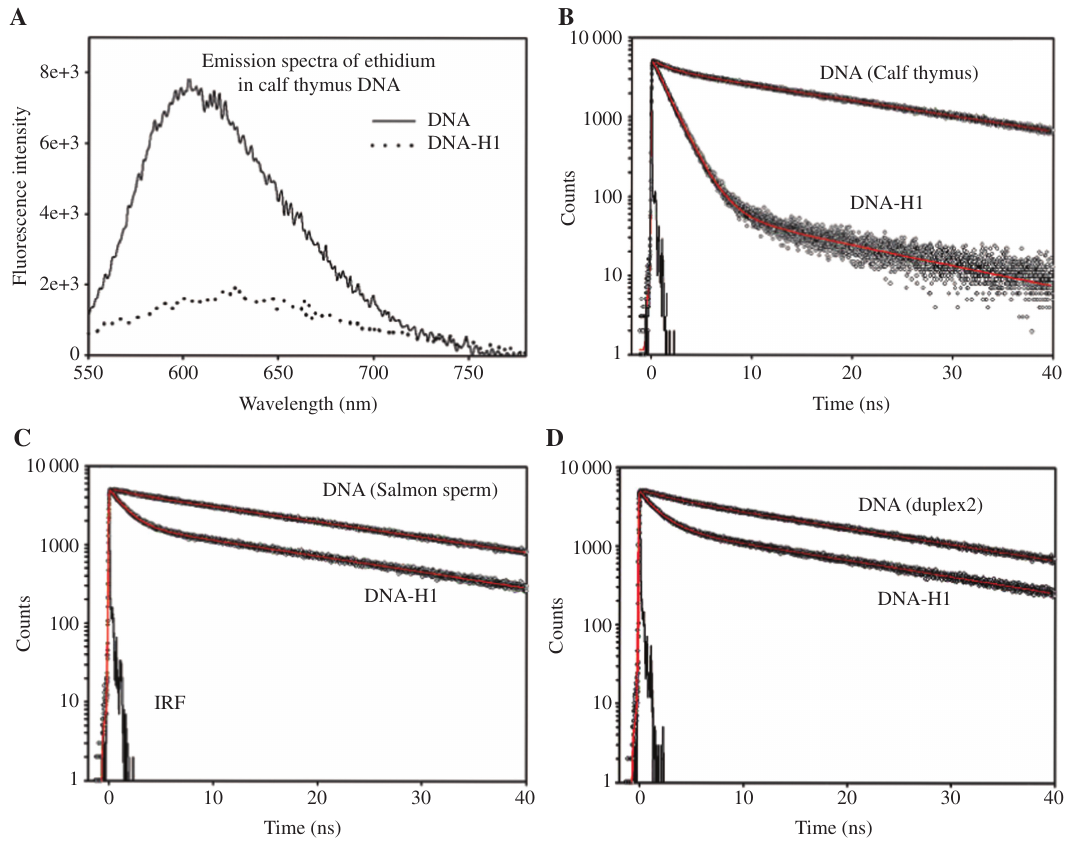
Figure 3 FRET study in DNA-Histone I complex. (A) Steady-state emission spectra of EtBr in calf thymus DNA and DNA-H1 complex are shown. Picosecond-resolved fluorescence transients of EtBr in (B) calf thymus DNA, (C) salmon sperm DNA, and (D) duplex2 and their condensates are shown. Solid lines indicate biexponential numerical fitting of the experimental data points. [Reprinted with permission from ref. (22) Copyright 2007, American Chemical Society.]